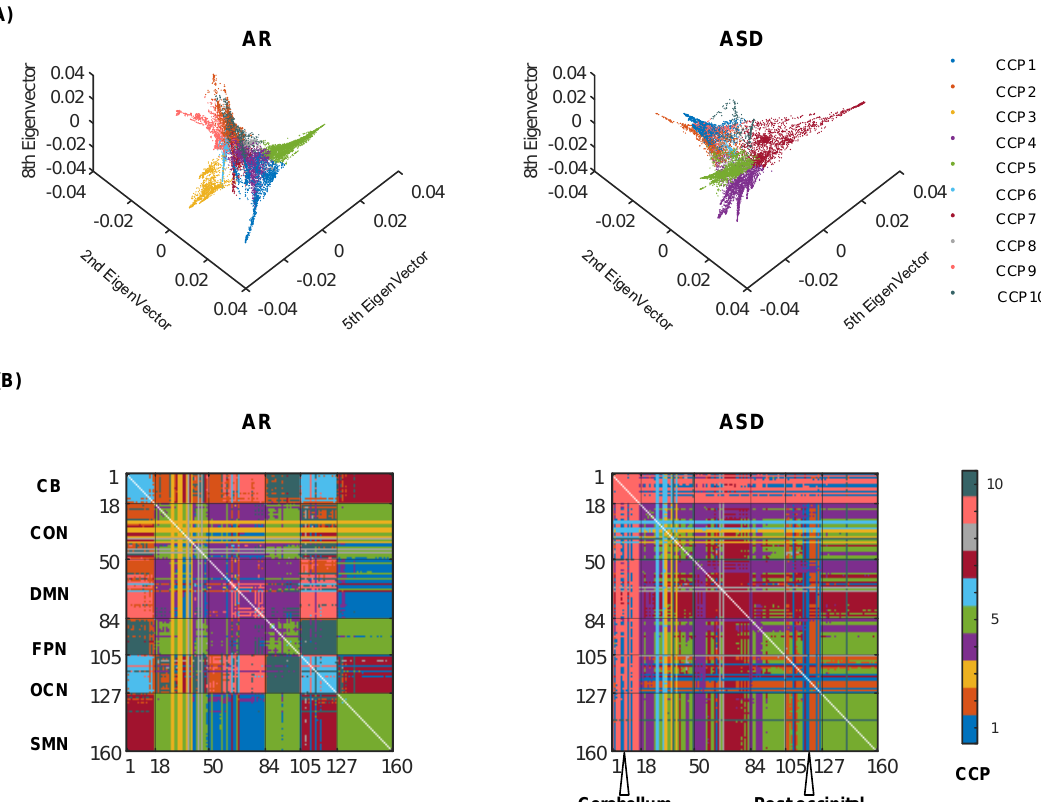
Figure 4. The CCPs for AR and ASD state. ( A ) The manifold structures of the CCPs for AR and ASD states are displayed in 2 nd , 5 th and 8 th dimensions. ( B ) The CCPs in the ROI-ROI index matrix reveal the functional couplings in the